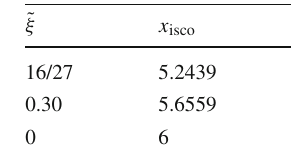
Table 1 The ISCO of the thin disk for selected values of ˜ ξ